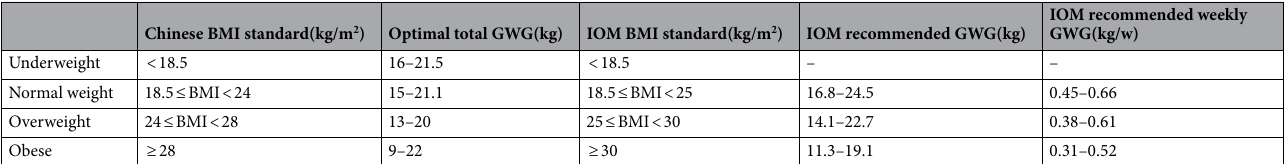
Table 3. The comparison between proposed optimal GWG and IOM recommended GWG grouped by prepregnancy BMI. BMI body mass index, GWG gestational weight gain, IOM Institute of Medicine.